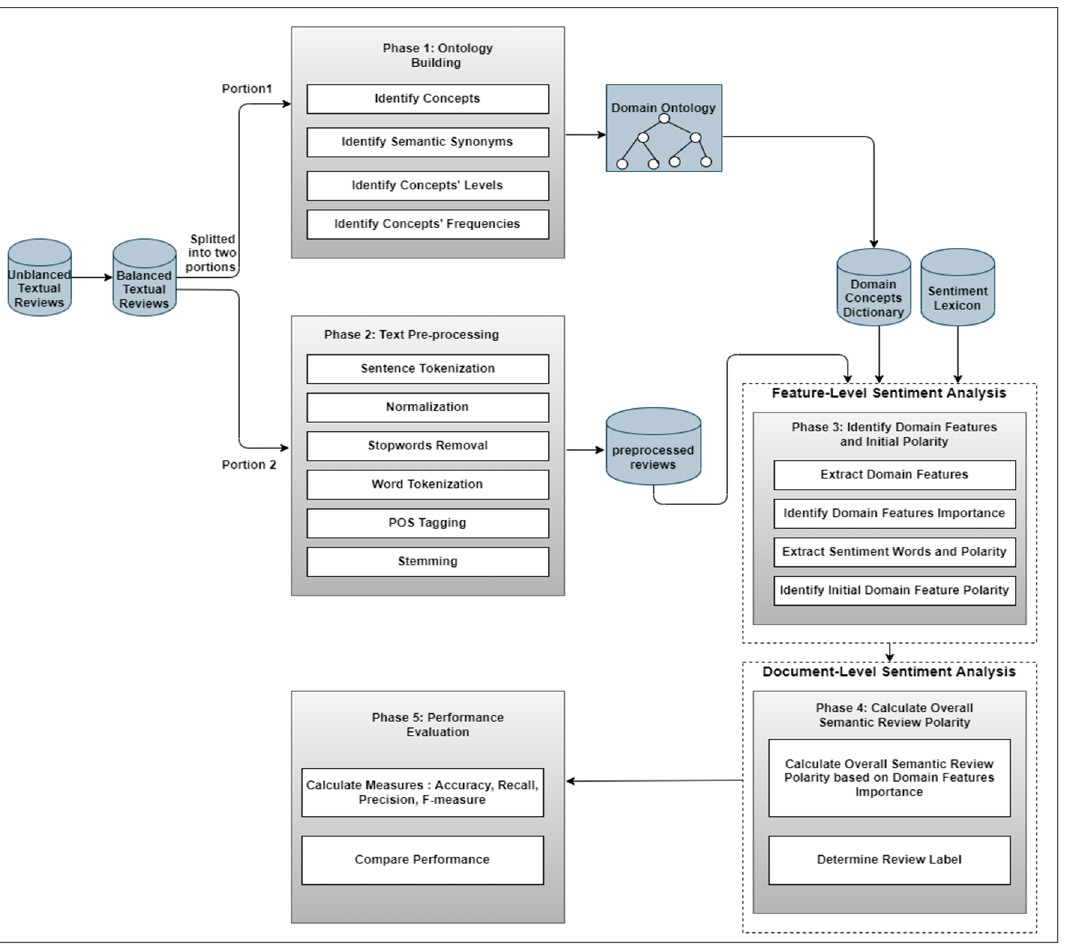
Figure 1. Overall approach design.